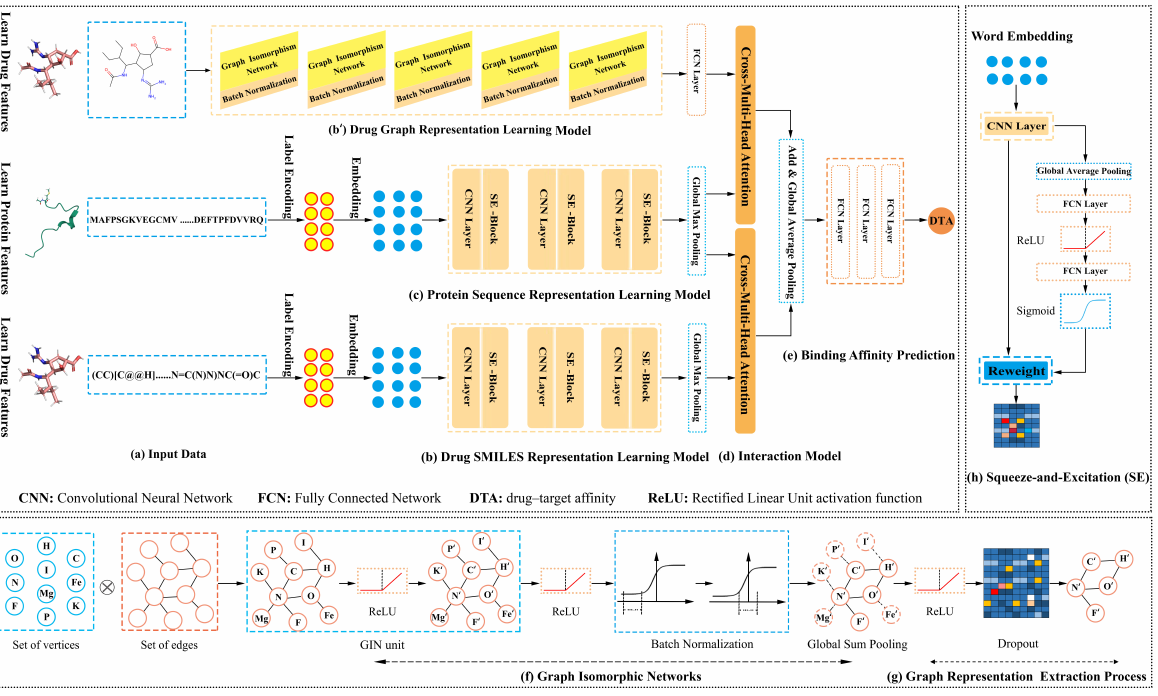
Figure 1. Architecture of the presented DoubleSG-DTA